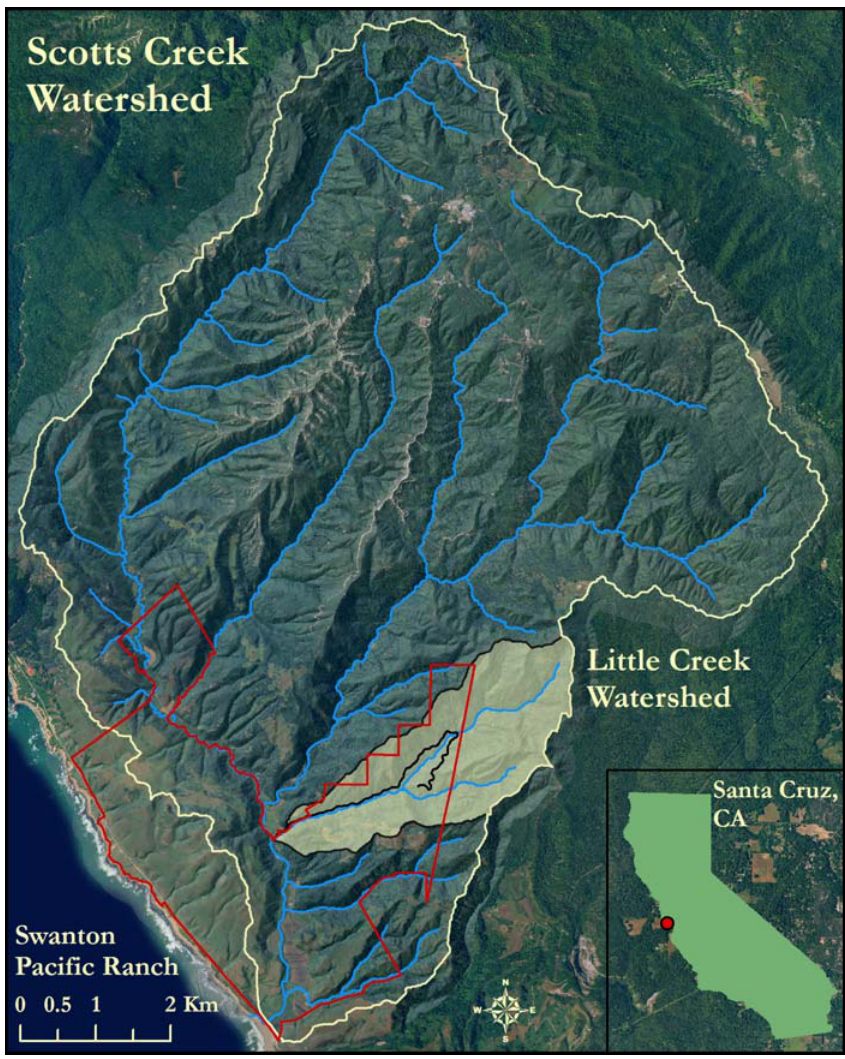
Figure 1. Little Creek watershed and Swanton Pacific Ranch boundaries shown within the context of the Scotts Creek